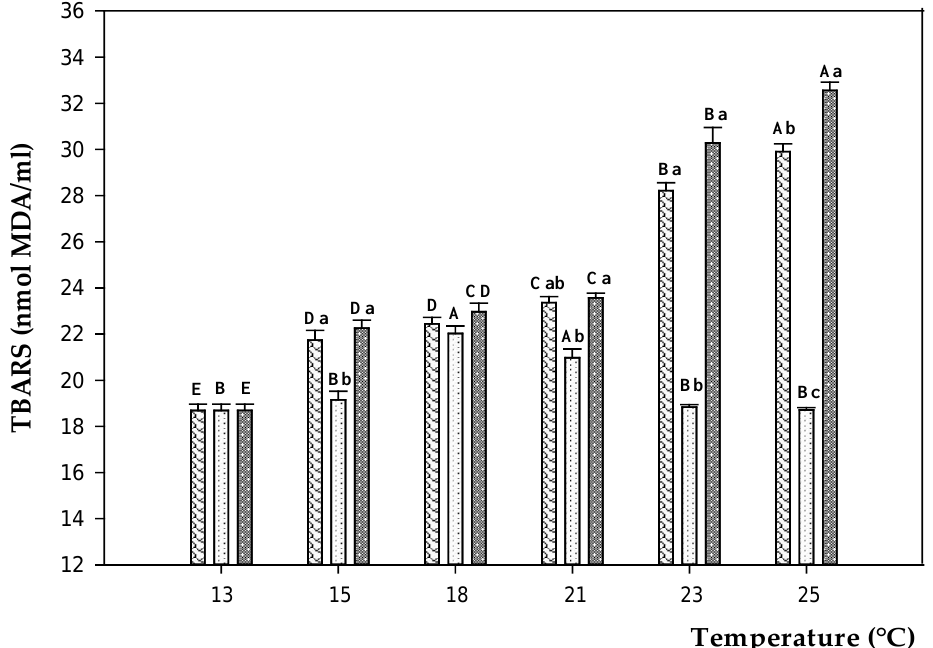
Temperature (°C) Figure 2. TBARS levels in sea bass fed on control diet (CD, Figure 2. TBARS levels in sea bass fed on control diet (CD, ) and experimental diets with different concentration of Figure 2. TBARS levels in sea bass fed on control diet (CD, ) and experimental diets with different concentration of Figure 2. TBARS levels in sea bass fed on control diet (CD, ) and experimental diets with different concentration of Figure 2. TBARS levels in sea bass fed on control diet (CD, ) and experimental diets with different concentration of oregano essential oil: 100 ppm (D100, ) and 200 ppm (D200, ) and, exposed to different water temperature (13, oregano essential oil: 100 ppm (D100, ) and 200 ppm (D200, ) and, exposed to different water temperature (13, concentration of oregano essential oil: 100 ppm (D100, oregano essential oil: 100 ppm (D100, ) and 200 ppm (D200, ) and, exposed to different water temperature (13, oregano essential oil: 100 ppm (D100, ) and 200 ppm (D200, ) and, exposed to different water temperature (13, 15, 18, 21, 23, and 25 °C). Data are reported as means ± standard deviations (at each temperature value, n = 12 per treat- 15, 18, 21, 23, and 25 °C). Data are reported as means ± standard deviations (at each temperature value, n = 12 per treat- 15, 18, 21, 23, and 25 °C). Data are reported as means ± standard deviations (at each temperature value, n = 12 per treat- 15, 18, 21, 23, and 25 °C). Data are reported as means ± standard deviations (at each temperature value, n = 12 per treat- to different water temperature (13, 15, 18, 21, 23, and 25 ◦ C). Data are reported as means ± standard ment). Different capital letters (A–E) indicate significant differences ( p < 0.05) among water temperature within the same ment). Different capital letters (A–E) indicate significant differences ( p < 0.05) among water temperature within the same ment). Different capital letters (A–E) indicate significant differences ( p < 0.05) among water temperature within the same ment). Different capital letters (A–E) indicate significant differences ( p < 0.05) among water temperature within the same deviations (at each temperature value, n = 12 per treatment). Different capital letters (A–E) indicate diet. Different lowercase letters (a–c) indicate significant differences ( p < 0.05) among diets within the same water temper- diet. Different lowercase letters (a–c) indicate significant differences ( p < 0.05) among diets within the same water temper- diet. Different lowercase letters (a–c) indicate significant differences ( p < 0.05) among diets within the same water temper- diet. Different lowercase letters (a–c) indicate significant differences ( p < 0.05) among diets within the same water temper- significant differences ( p < 0.05) among water temperature within the same diet. Different ature. ature. ature. ature.